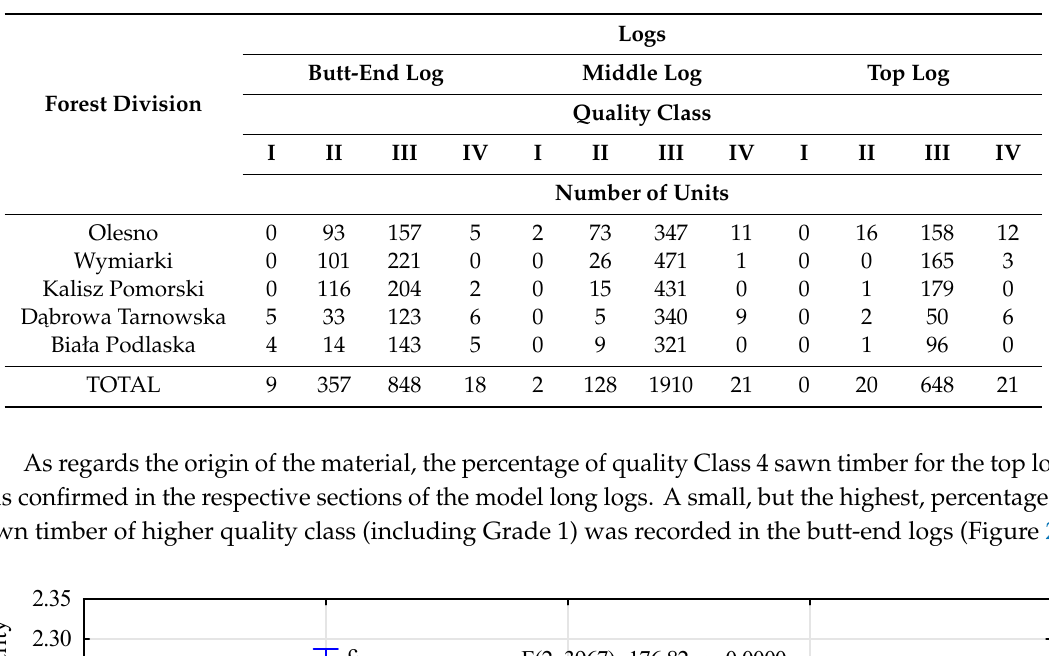
Table 2. The structure of the quality of coniferous sawn timber obtained from the test material according to PN-75 / D-96000 for individual forest divisions.